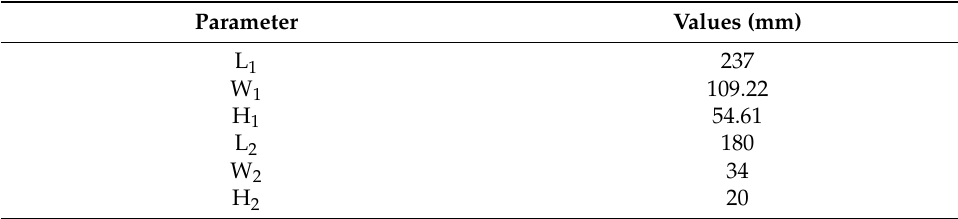
Table 1. Structure dimension table of the oblique aperture ridge waveguide.